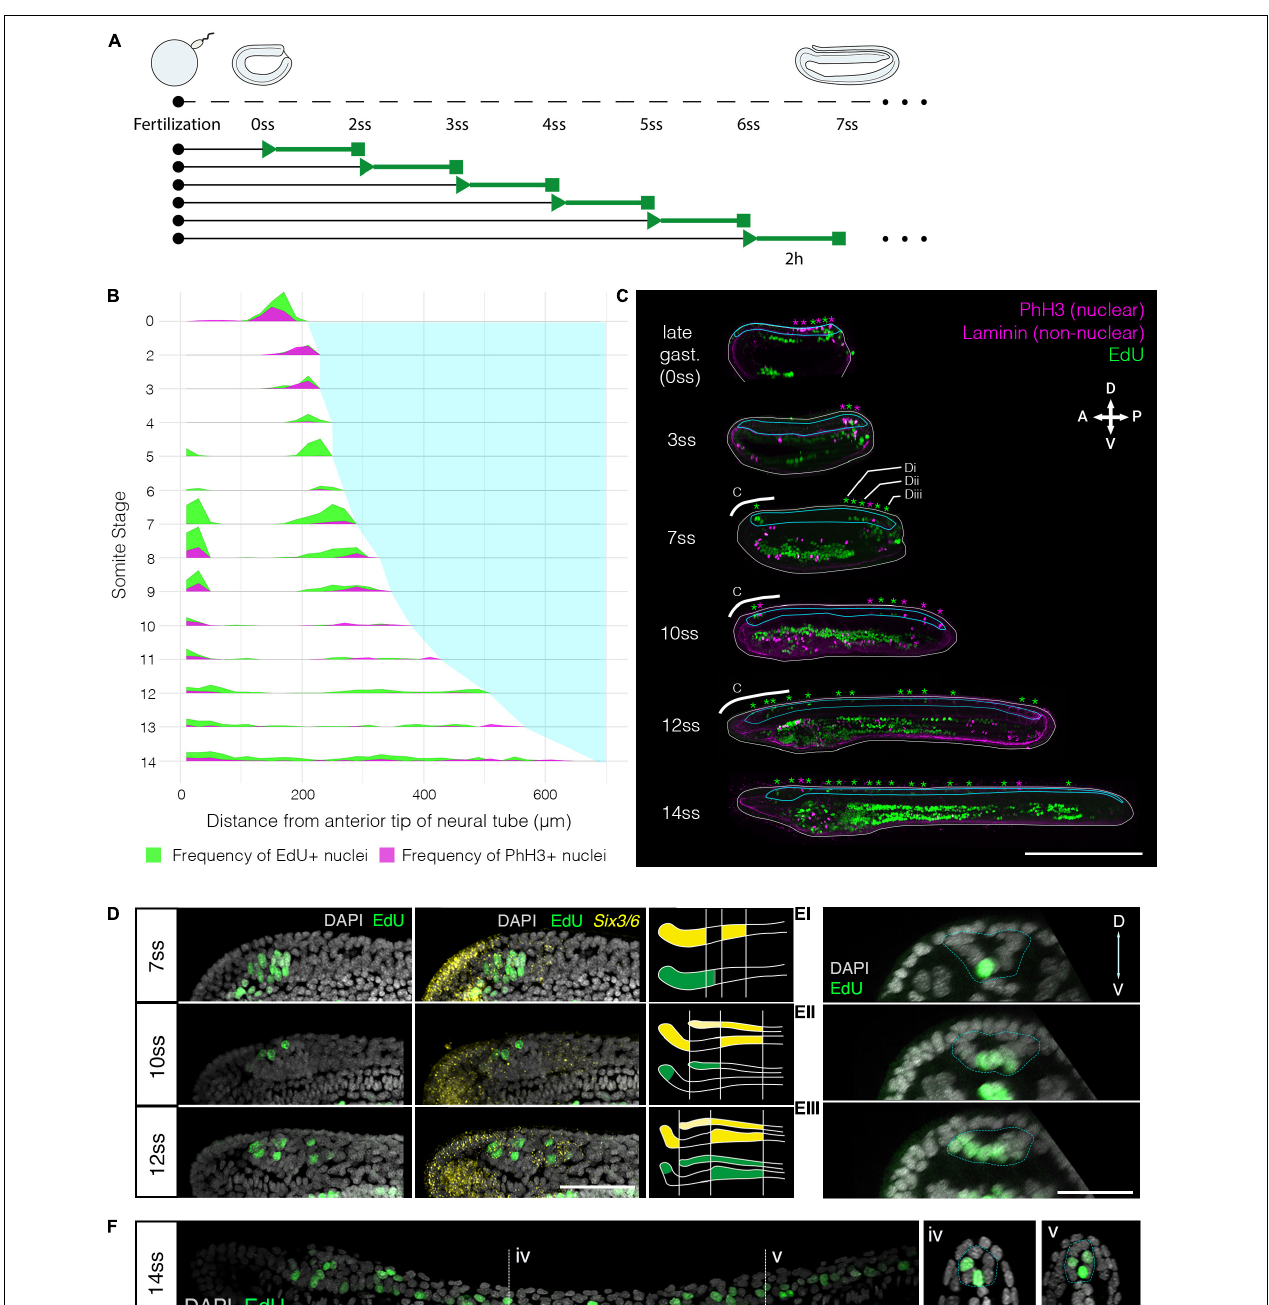
FIGURE 1 | Cell division restricts to two polarised mitotic domains during neural tube morphogenesis. (A) Experimental design of EdU pulses experiments. Two hour EdU pulses are represented in green, while squares indicate time of fixation. The same approach was taken every 2 h for embryos up to the 14 ss stage. (B) Proliferation landscape for the neural tube, showing mean frequency of EdU-positive (EdU exposure for 2-h before fixation) and PhH3-positive nuclei in 20 µ m bins of the anteroposterior axis at successive somite stages. “0-somite stage” refers to late gastrula 2-h before onset of somitogenesis. n = 114 embryos. (C) Mid-sagittal sections for representative embryos included in panel (A) , showing distribution of EdU-positive and PhH3-positive nuclei in each tissue of the body axis, which are delineated by laminin immunostaining. White lines outline the whole embryo, light blue lines outline the neural tube. Asterisks mark location of EdU/PhH3-positive nuclei using the same colour code. Scale bar is 150 µ m. (D) Lateral z-projections of the cerebral vesicle at 7, 10, and 12 somite stages, at the level indicated by thick white lines in panel (C) , showing EdU incorporation and co-localisation with Six3/6, using HCR in situ hybridisation. Scale bar is 50 µ m. Brain patterns are schematically represented and summarised on the right side of the panel in the same colour code. (E) Serial transverse sections through a 7-somite stage embryo at the posterior positions illustrated in panels (C,Ei–iii) , showing the EdU detection profile. Neural tube is outlined with a dashed blue line. Scale bar is 30 µ m. (F) Lateral projection of 14-somite stage embryo, with representative transverse sections at the indicated positions: iv and v, where the neural tube is outlined with a light blue dashed line. Scale bar is 50 µ m.